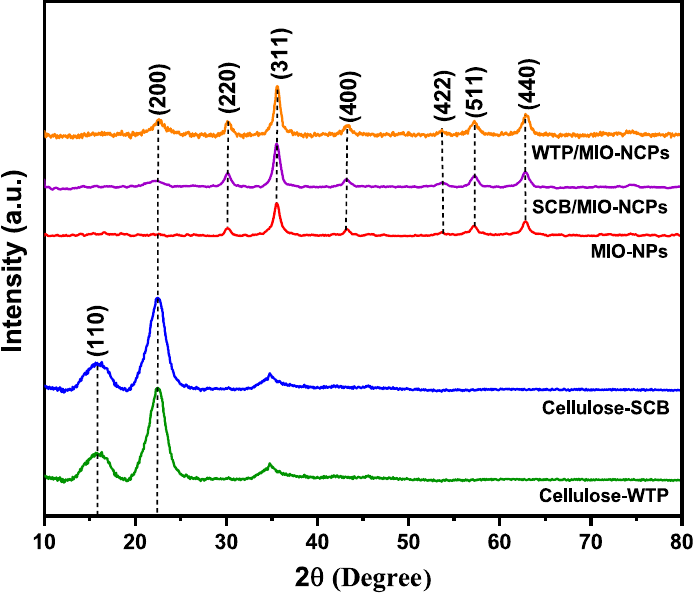
Figure 8. XRD patterns of cellulose-WTP, cellulose-SCB, SCB/MIO-NCPs, WTP/MIO-NCPs, and MIO-NPs.